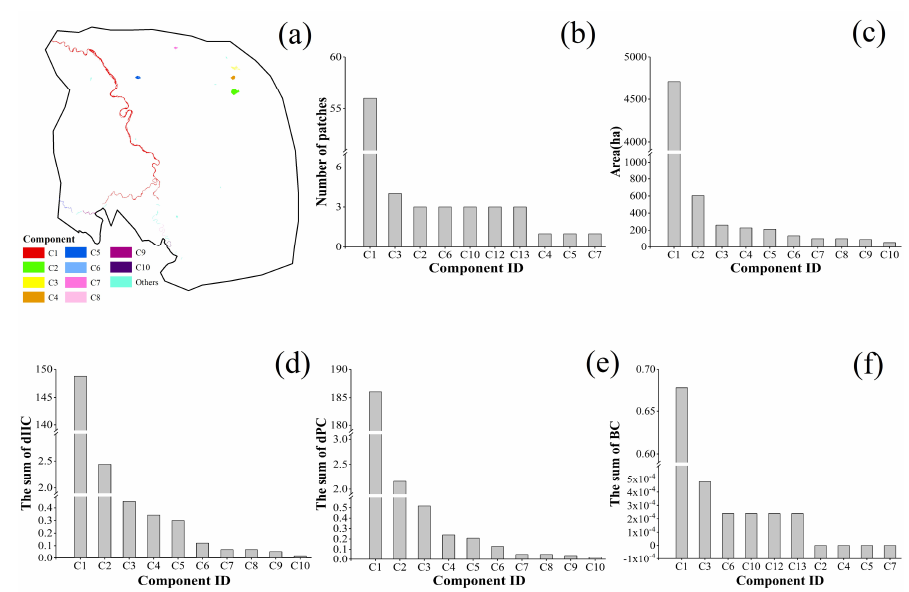
Figure A1. Statistics of different indices for the top 10 components in terms of connectivity for 2000. ( a ) Distribution of components, ( b ) Number of patches (n), ( c ) Area of components (ha),